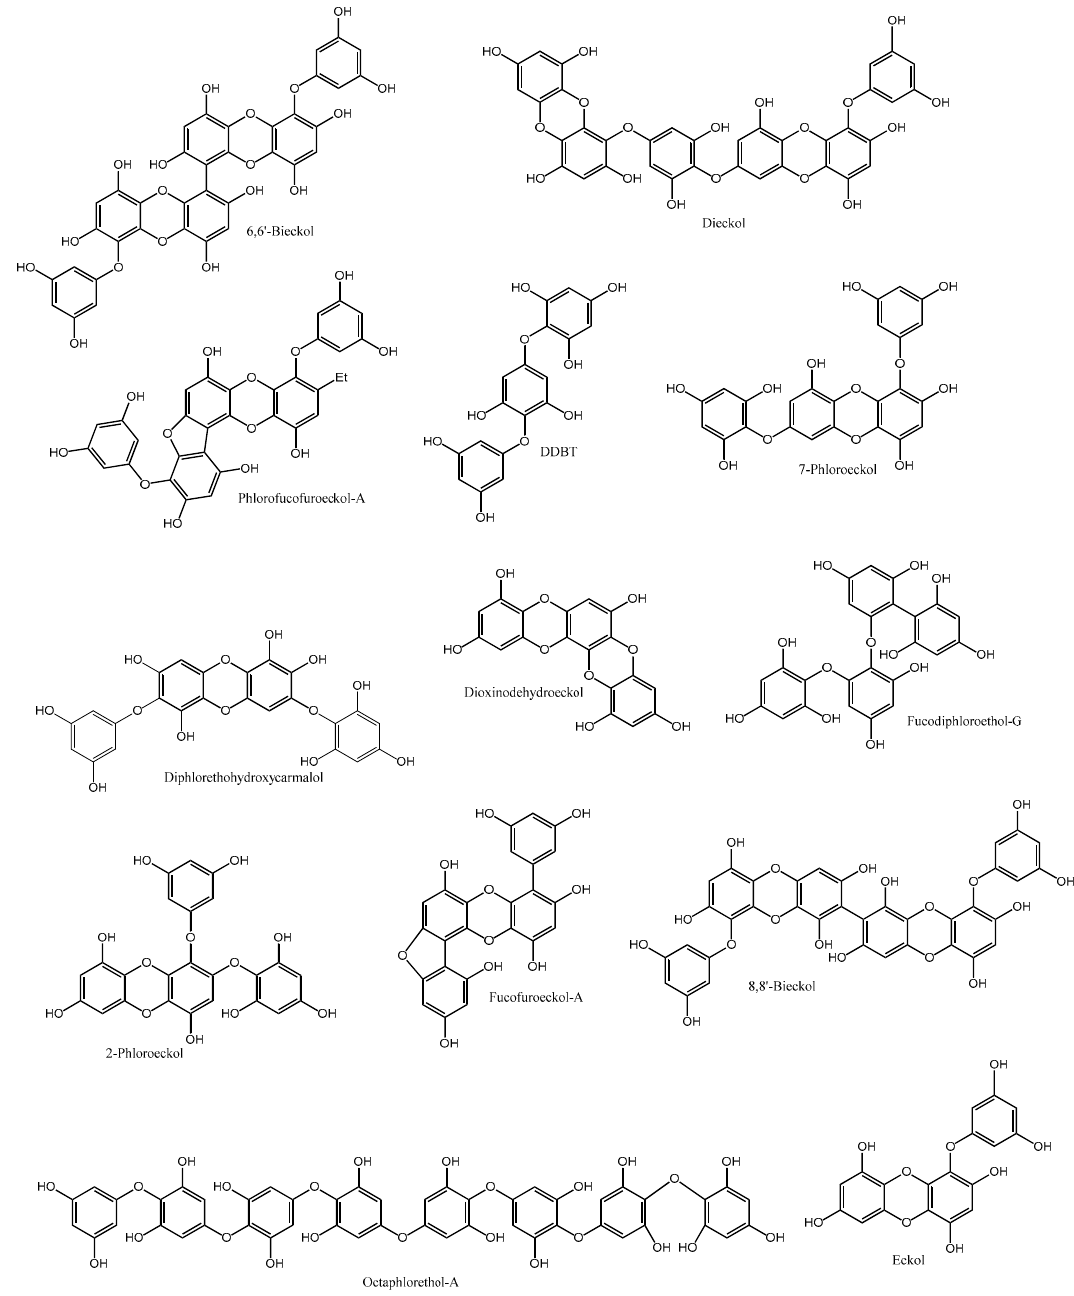
Figure 4. Chemical structures of phlorotannins with anti-diabetic activity isolated from brown seaweeds.